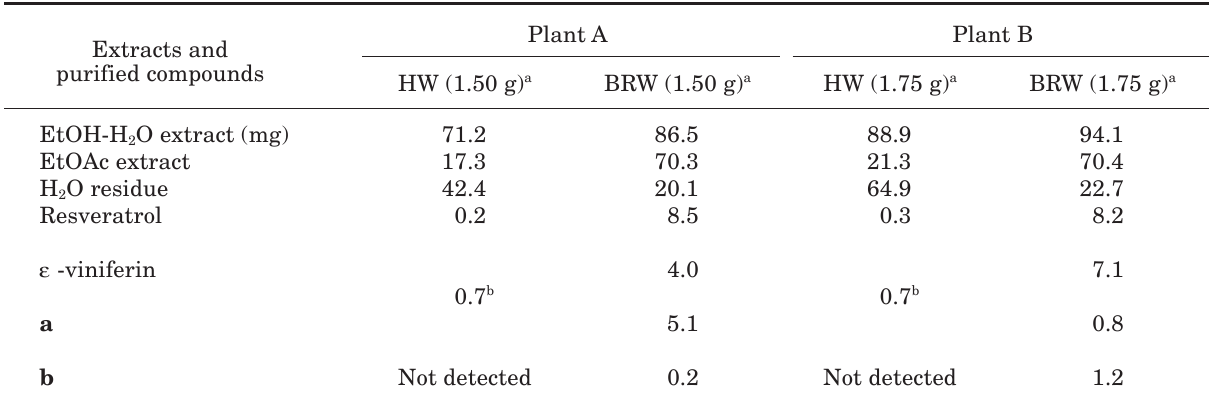
Table 1. Absolute amounts (mg) of extracts, residues and purified compounds from healthy wood (HW) and brown- red wood